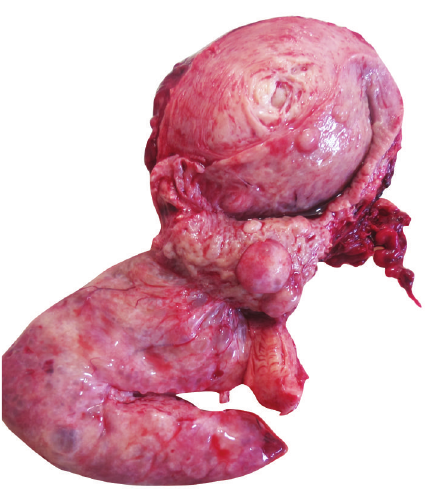
Figure 1: Gross photograph of a giant endometrial polyp in the lower left side of the figure, with smooth surface, cystic changes, and soft consistency. The measurement of the polypoid lesion is 10 × 9.5 × 7 centimeters in